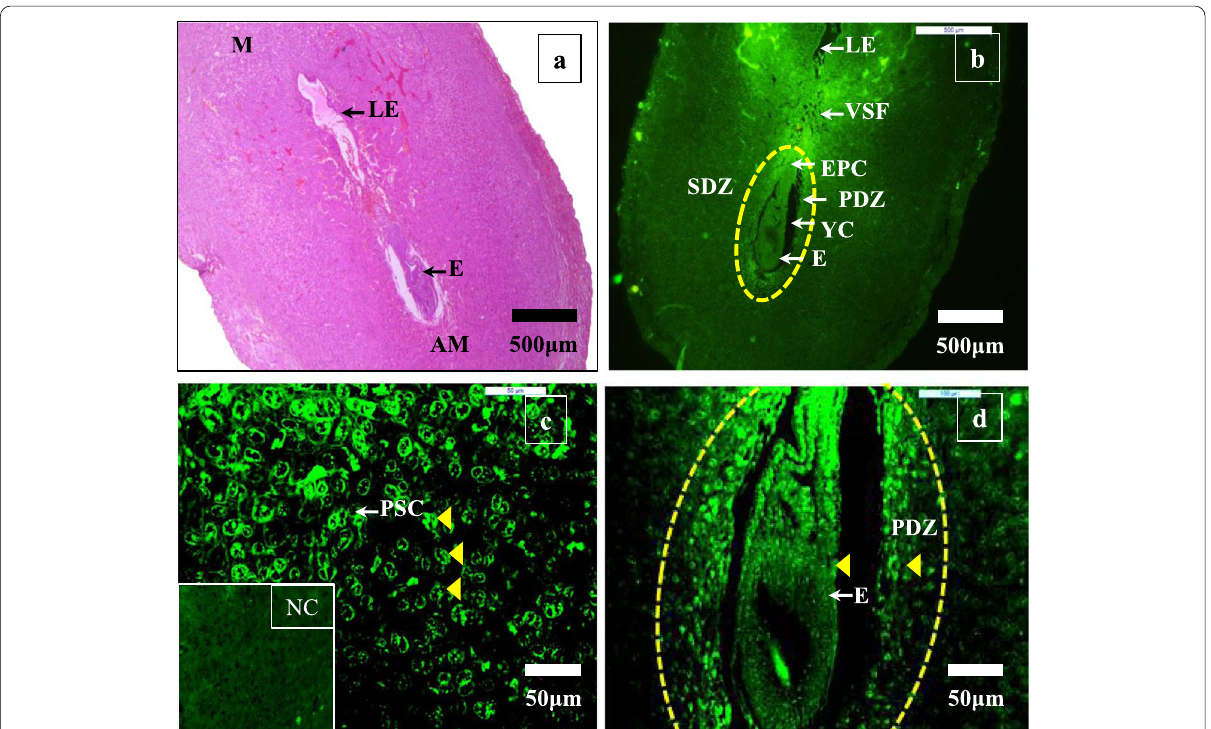
Fig. 5 Immunofluorescence of KLF5 on D7 mice uterus using FITC-conjugated antibody. The protein was localized in the luminal epithelium (LE), proliferating stromal cell (PSC), and embryo (E). The arrowhead indicates the expression. Original magnification: a 5 primary decidual zone; SDZ, secondary decidual zone; YC, yolk cavity; EPC, ectoplacental cone; VSF, vascular sinusoidal fold; M, mesometrial pole; AM, antimesometrial pole; NC, negative